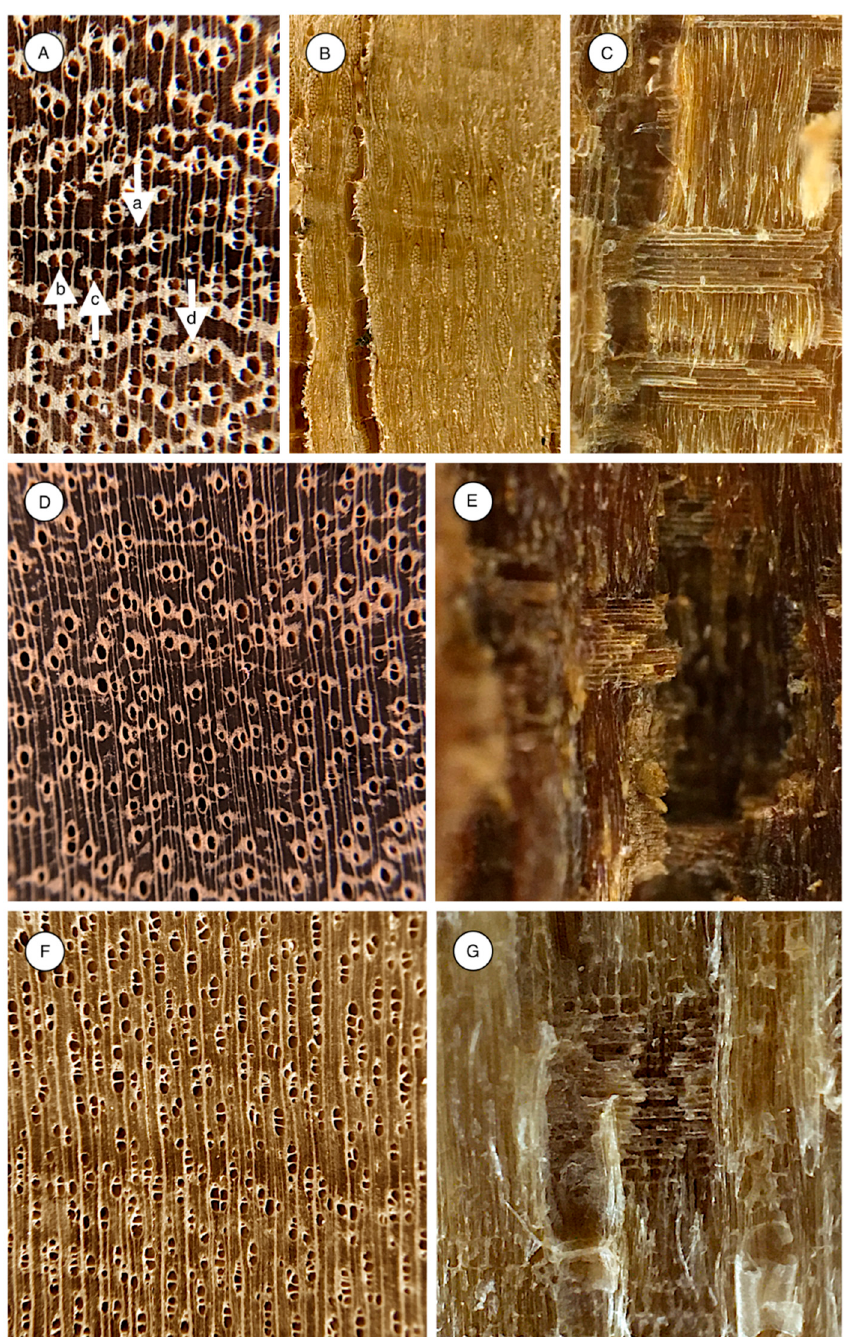
Figure 10. Elements visible with 400 × lens in hardwoods. Pericopsis elata (Harms) Meeuwen. ( A ) ( a ) Marginal axial parenchyma; ( b ) confluent axial parenchyma; ( c ) lozenge-aliform axial parenchyma; ( d ) white deposits. ( B ) Storied rays, 1 to 3 cells wide. ( C ) Homocellular rays with procumbent cells. Platymiscium parviflorum Benth. ( syn. Platymiscium pleiostachyum Donn.Sm.). ( D ) Winged-aliform and confluent axial parenchyma. ( E ) Homocellular rays with procumbent cells. Prunus Africana (Hook.f.) Kalkman. ( F ) Diffuse-porous wood with vessels in radial multiples of 2, 3, 4 or more. ( G ) Procumbent body ray cells with one row of upright and/or square marginal cells and also with 2 to 4 rows. Platymiscium Vogel comprises 19 species distributed in South America, Central America and Mexico. Only P. parviflorum ( syn. P. pleiostachyum ) is listed in CITES, making it difficult to identify.